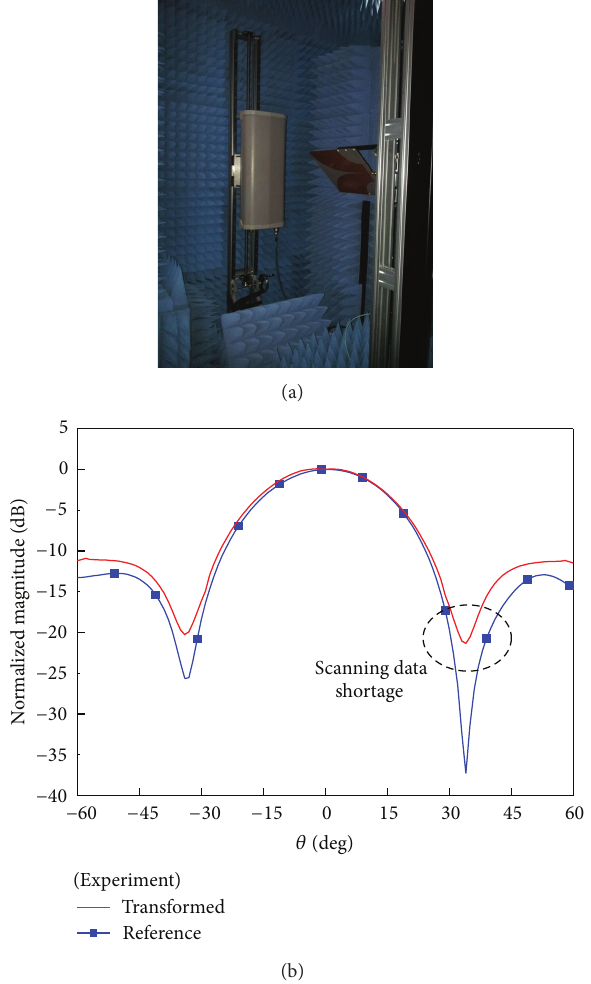
Figure8:Anotherexperimentofthebase-stationantennaoperating at 859 MHz (a) Photograph (b) Transformed and reference far-field